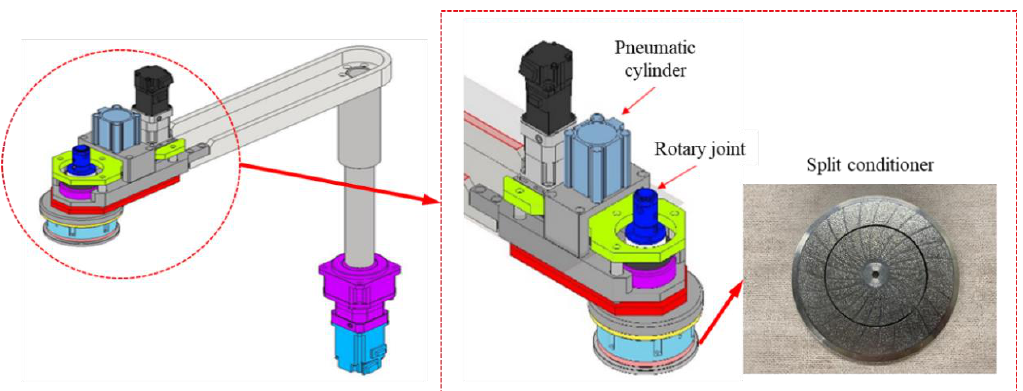
Figure 2. Swing-arm conditioning system and split conditioner used in this study.